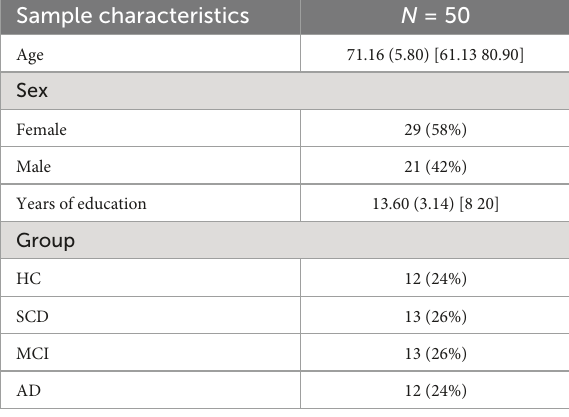
TABLE 1 Demographic characteristics of the selected DELCODE dataset used in this study. Sample